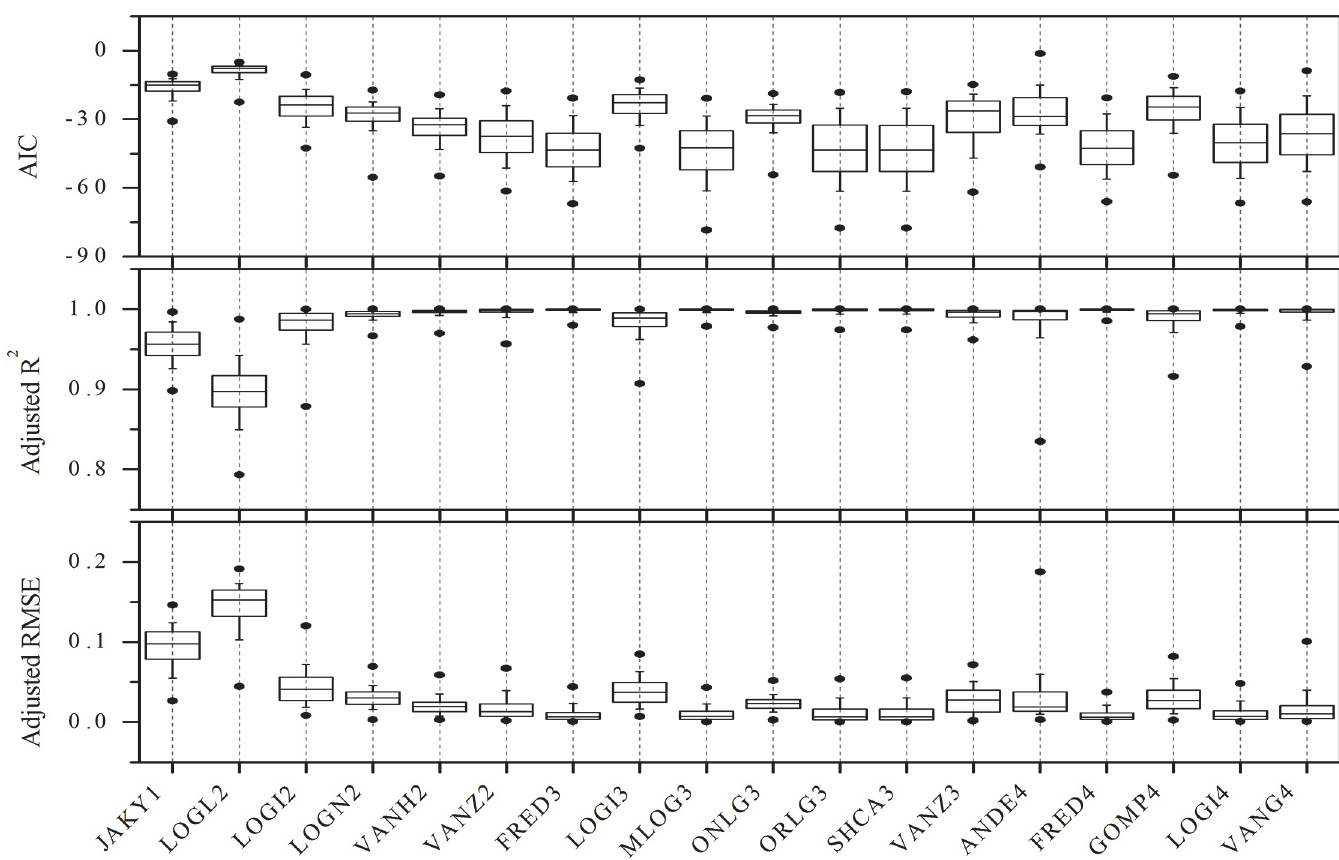
Fig 3. Performance of eighteen mathematical functions fitted to six-class (2, 20, 50, 125, 250 and 1000 μ m) particle size distributions (PSD) based on soil data obtained with the laser diffraction method (LDM), in terms of Akaike ’ s information criterion ( AIC ), adjusted R 2 , and adjusted root mean square error ( RMSE